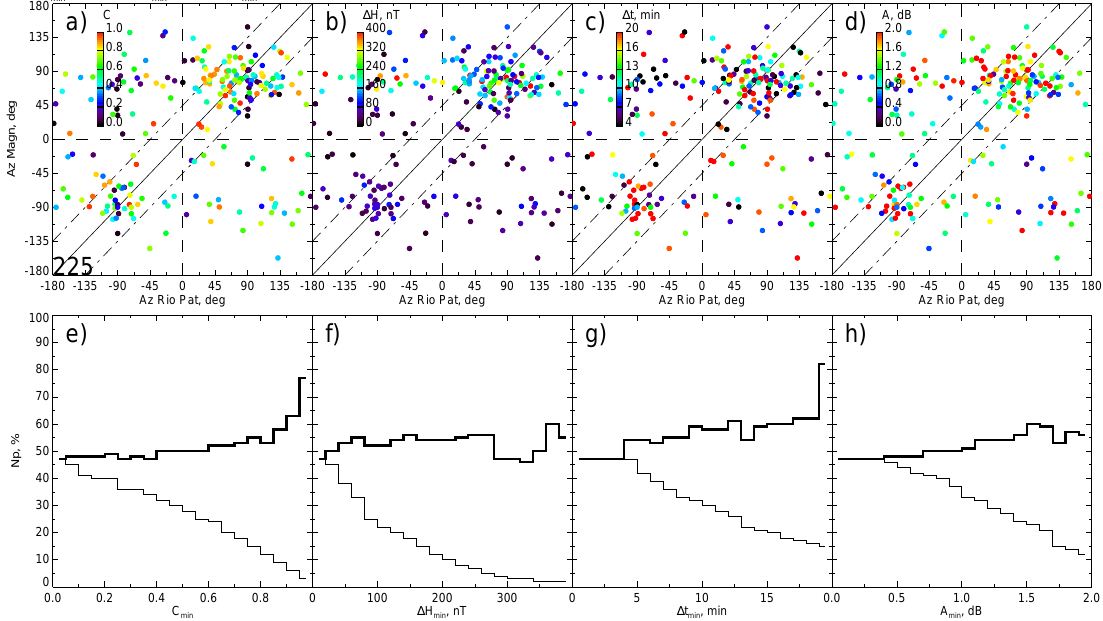
Fig. 3. Scatter plots of the azimuth of the electrojet plasma flow versus the azimuth of the absorption patch drift. Each dot is colour coded in (a) correlation coefficient C , (b) total magnitude of horizontal perturbations 1H , (c) patch duration 1t , and (d) absorption intensity A . The colour code bar is shown in the top left corner of each panel. The total number of points is indicated in the bottom left corner of panel (a). Panels (e) – (h) show by a heavy black line the percentage of points above a certain threshold in parameter from a respective panel (a)–(d) that is located within 45 ◦ of the ideal coincidence line. The thin line shows the percentage of points within 45 ◦ and above a certain threshold with respect to the total number of